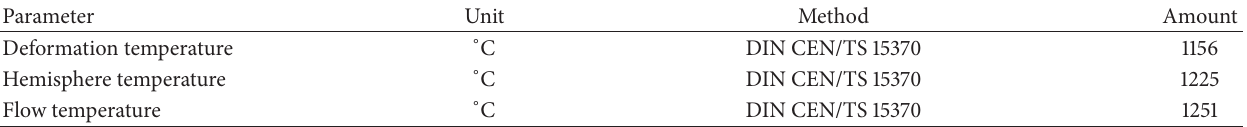
Table 2: Ash melting behavior (ash fusion temperatures) (oxidizing atmosphere)